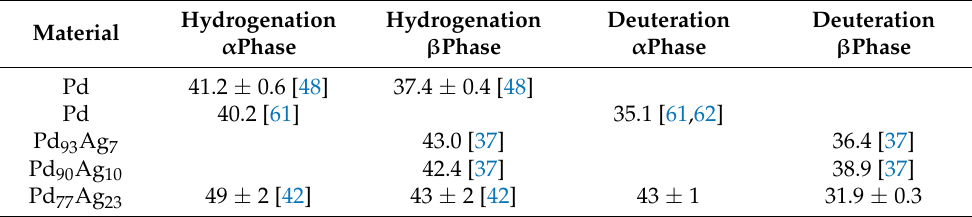
Figure 2. Van’t Hoff plot for Pd 77 Ag 23 at fixed D/M (the number of deuterium atoms per atom of metal) and best fit lines to calculate the hydrogenation enthalpy. Table 1. Comparison of the hydrogenation/deuteration enthalpy values (in kJ/mol) for the presently investigated Pd 77 Ag 23 sample with those of similar Pd-based materials. Uncertainties are reported where available from the literature data.